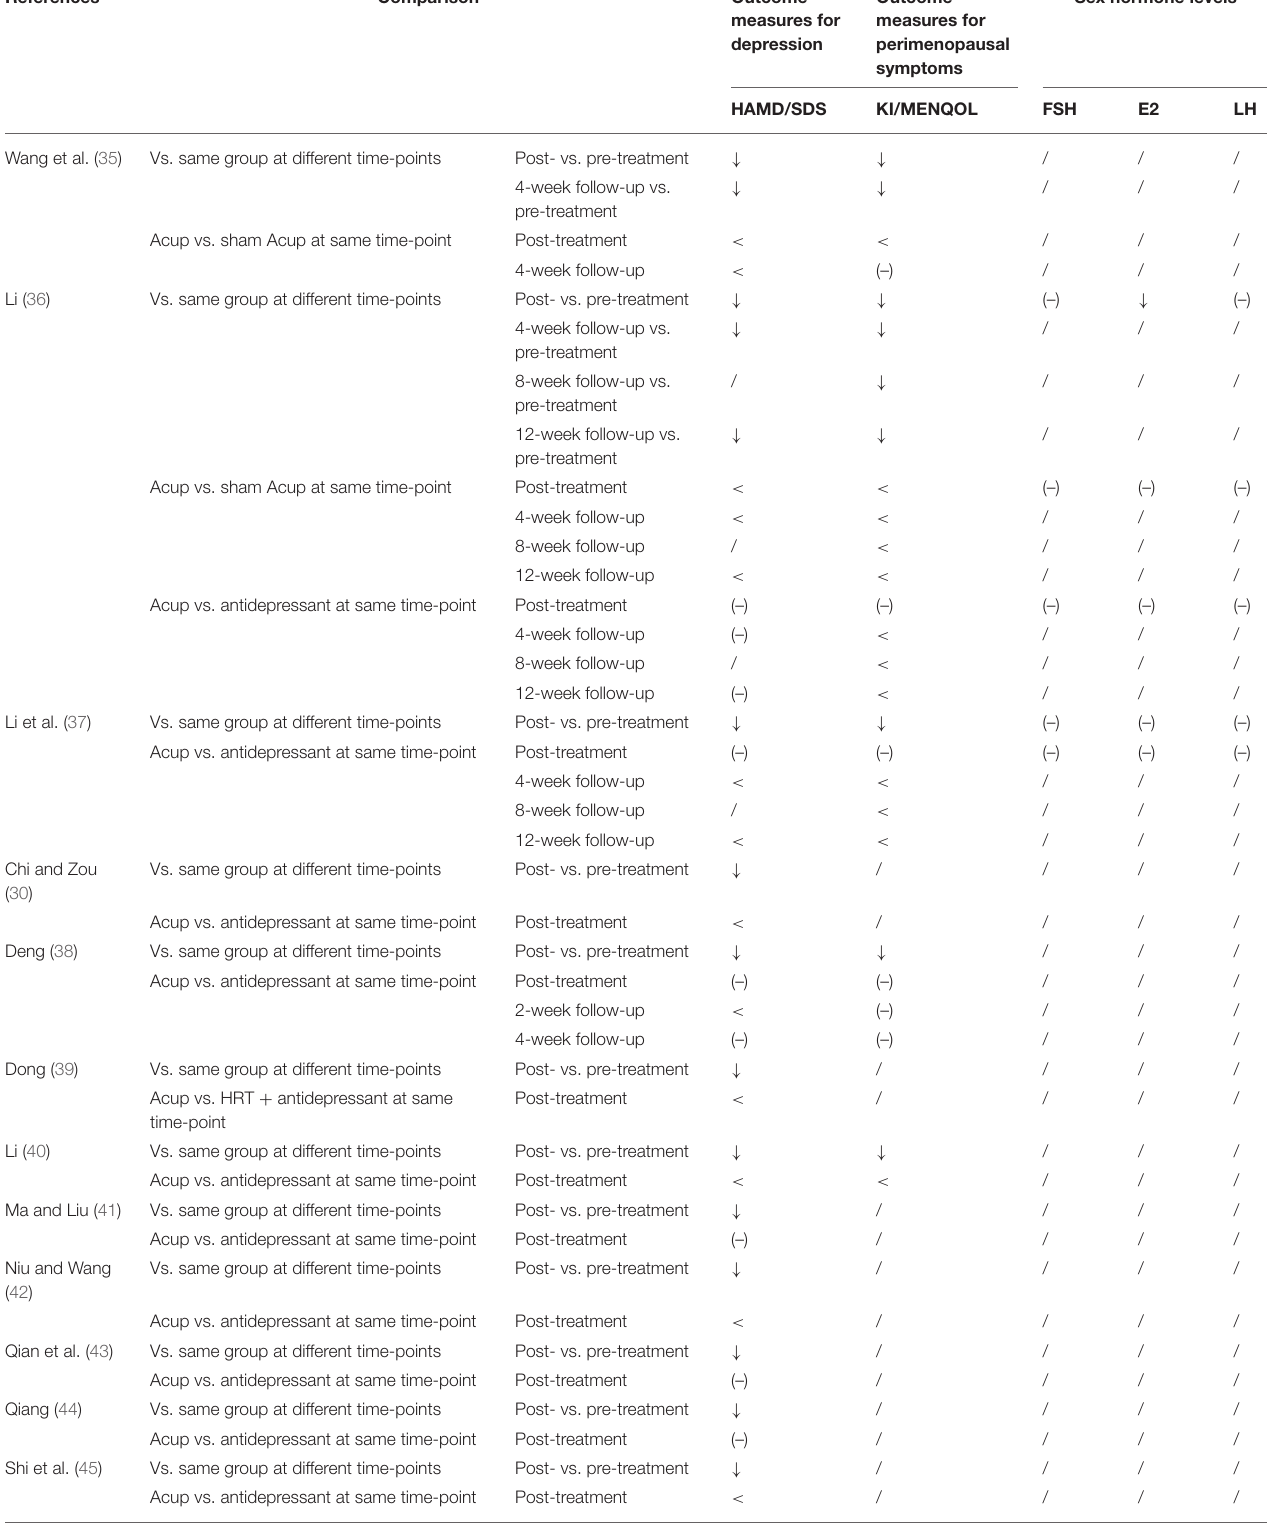
TABLE 2 | Trends of major outcomes for depression and perimenopausal symptoms in acupuncture (OR acupuncture + antidepressant/HRT) and comparison with controls in each